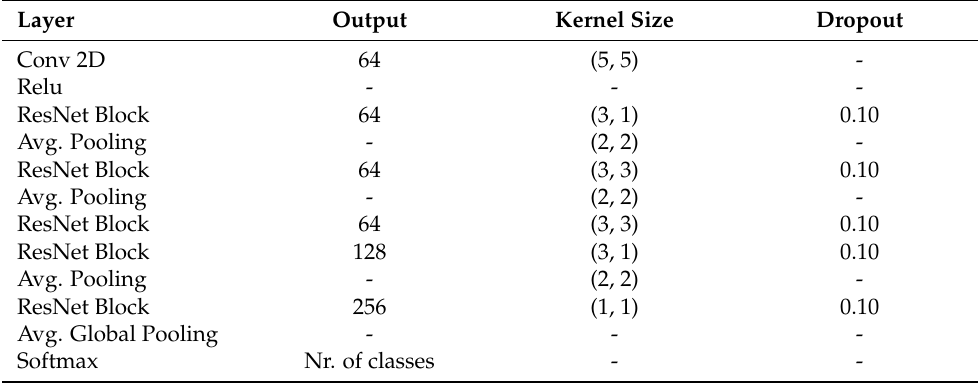
Table 2. CNN420 Resnet Architecture with 420k parameters and average (avg.) pooling between ResNet blocks. Details on the ResNet block are explained in